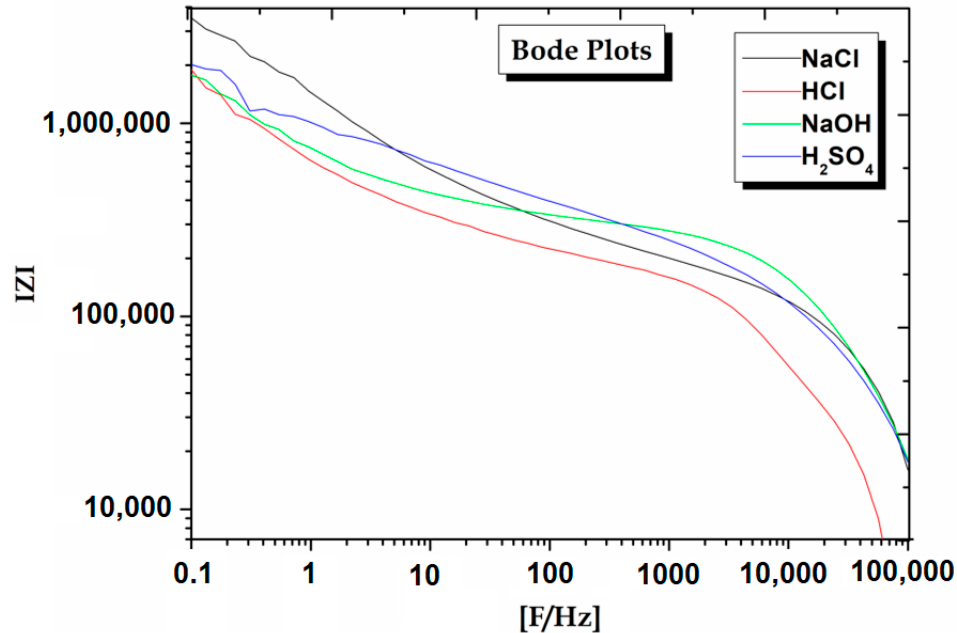
Figure 6. EIS Bode plots of 17.5%B 4 C/Al-Mg-Si AMCs obtained in various environments.